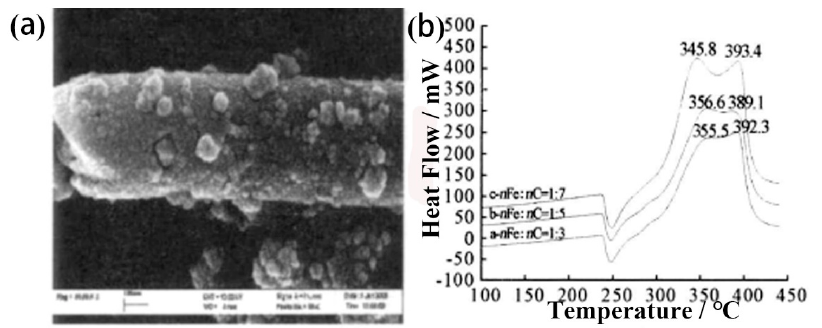
Figure 25. ( a ) SEM image of Fe 2 O 3 /CNTs composite particles; ( b ) DSC curves of AP with different ratio of nFe 2 O 3 : nCNTs. ( a , b ) Reproduced with the permission of ref. [114]. Copyright 2008,